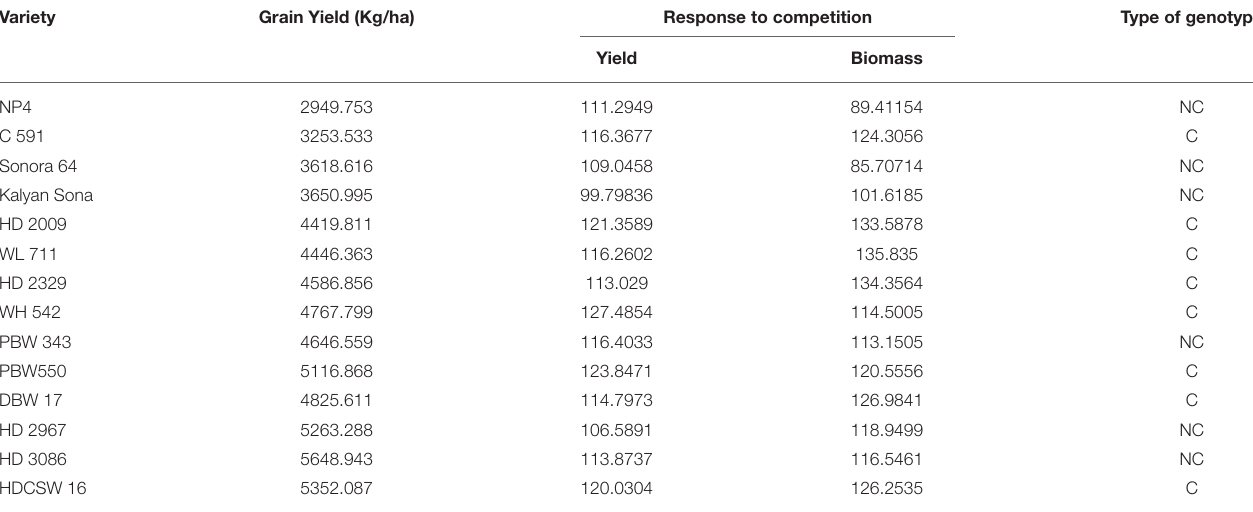
TABLE 2 | Grain yield and response to competition for yield and biomass in cultivars released over the years. Variety